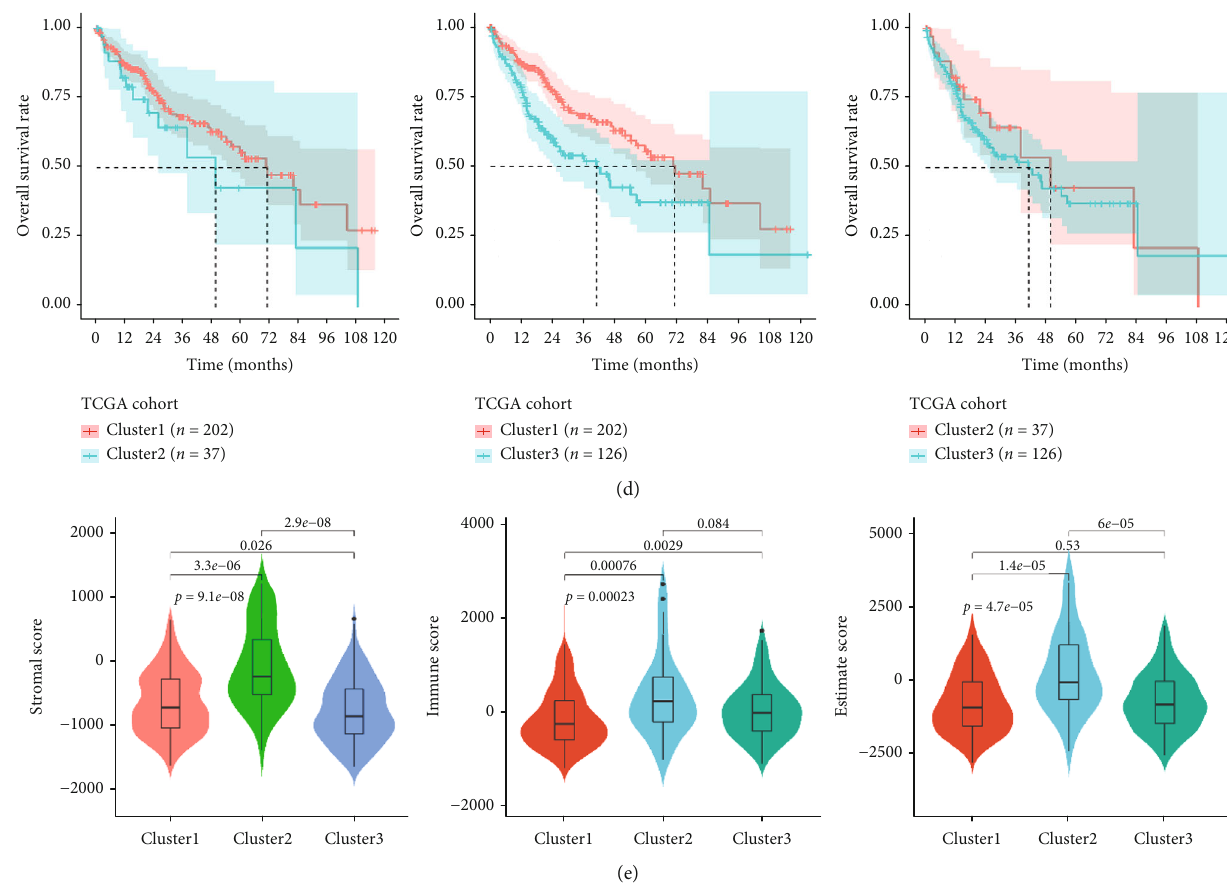
Figure 1: Molecular subtypes identi fi cation based on ERSRGs. (a) The optimal number of clusters was identi fi ed as three based on the cophenetic. (b) 365 HCC samples were separated into three subcategories. (c) Substantial di ff erences were found between patients in the three groupings. (d) Two-by-two comparisons were made between the three groups. (e) Stromalscore, immunescore, and ESTIMATEscore were di ff erent among the three